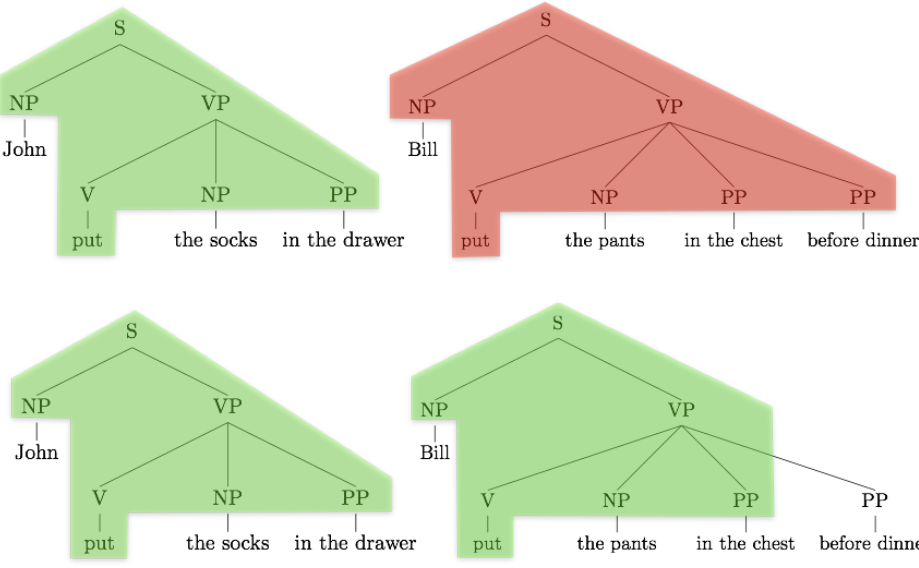
Figure 4: The argument-only model versus the argument-modifier